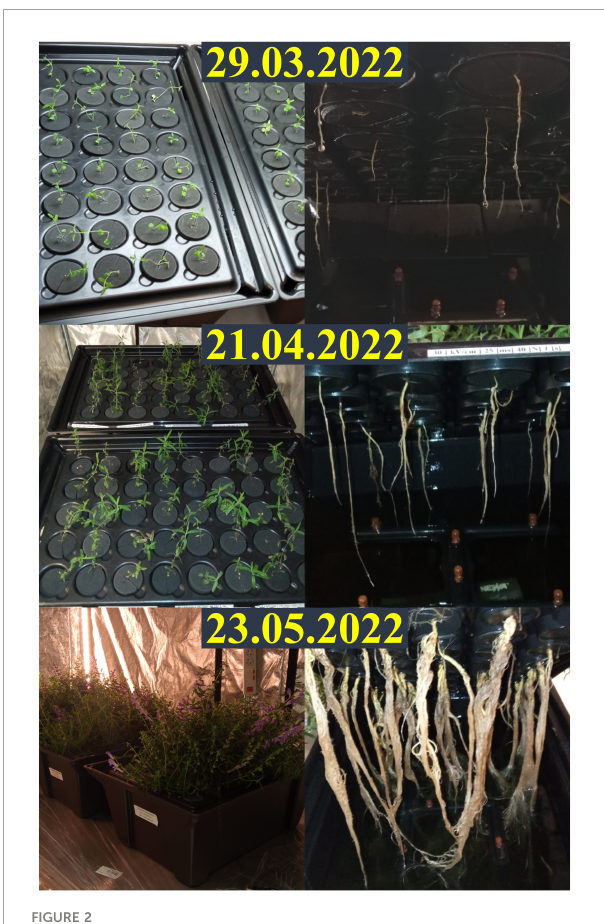
FIGURE 2 Overall monthly development of S. baicalensis shoots and